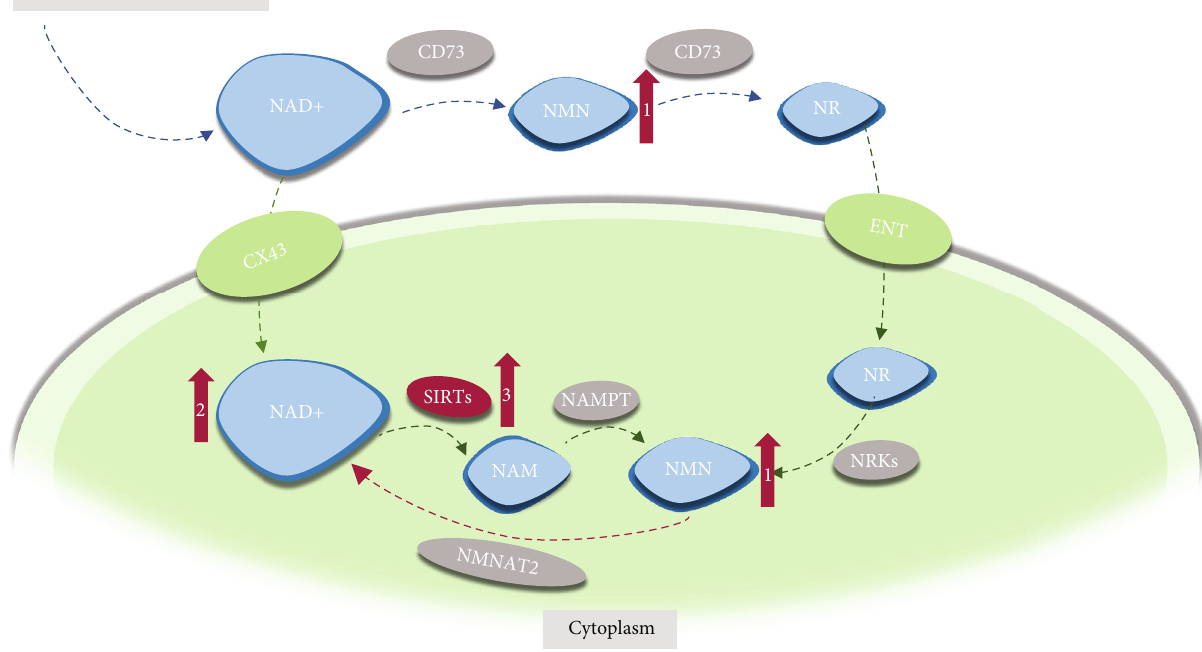
Figure 2: The supplementation of NMN may restore NAD level and SIRT1 activity. The circles fi lled with gray suggest involved enzymes, while the blue suggest related intermediates. The red arrows with a number on it illustrate the in fl uence of NMN supplementation in order. NMN: nicotinamide mononucleotide; NR: nicotinamide riboside; ENT: equilibrative nucleoside transporters; CX43: connexin 43; NAMPT: nicotinamide phosphoribosyl transferase; NRK: nicotinamide riboside kinase 1; NMAT2: nicotinamide mononucleotide adenylyltransferase; NAM: